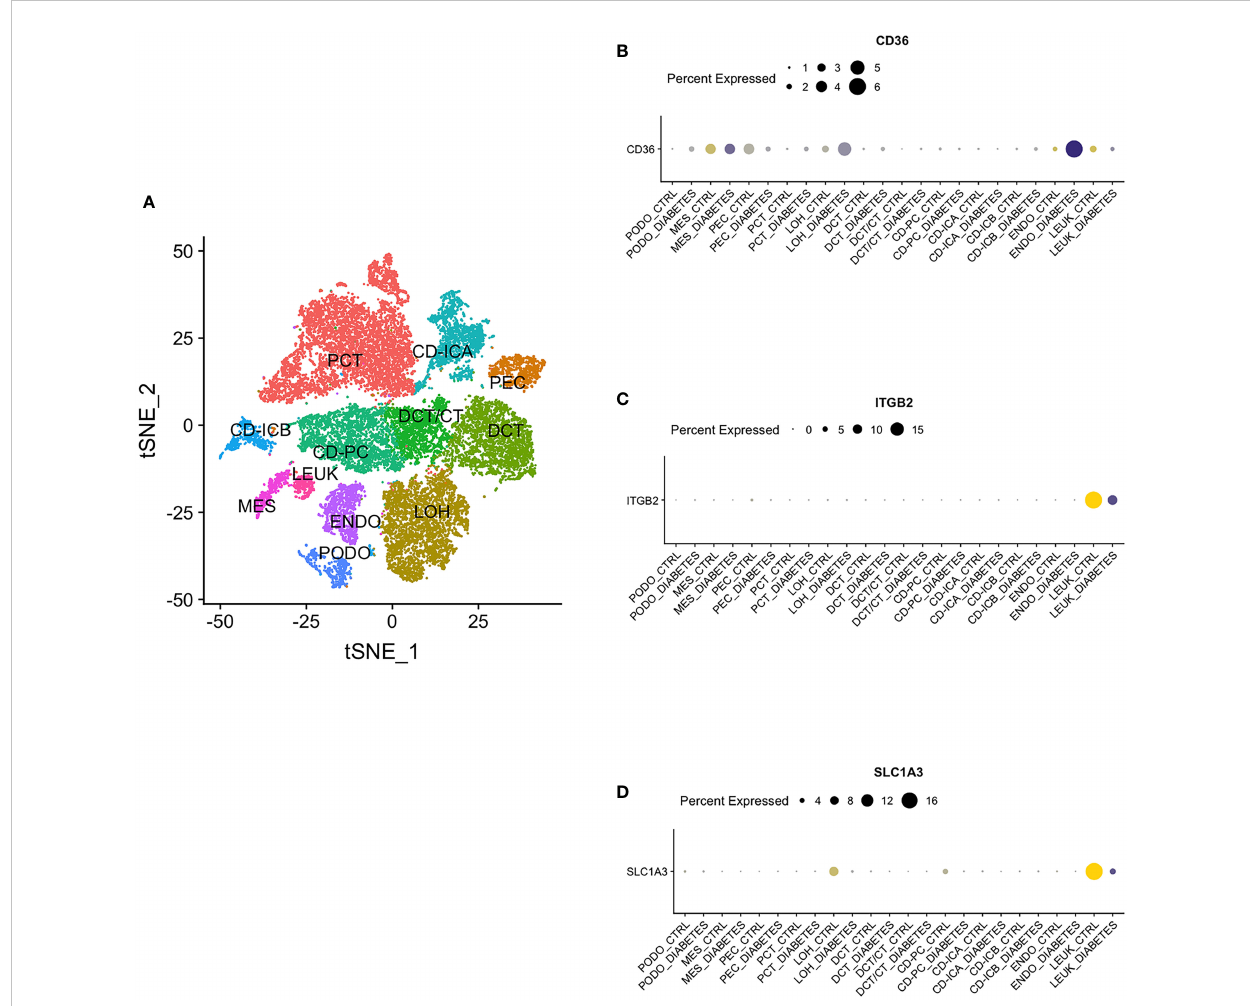
FIGURE 12 Single Nucleus RNA Sequencing. (A) The distribution of hub genes in 12 cell groups. (B) CD36. (C) ITGB2. (D) SLC1A3. PCT, proximal convoluted tubule; CD, collecting duct; ICA, Type A intercalated cells; ICB, Type B intercalated cells; PEC, parietal epithelial cells; PC, principal cell; DCT, distal convoluted tubule; CT, connecting tubule; LOH, loop of Henle; PODO, podocyte; ENDO, endothelium; MES, mesangial cell; LEUK,